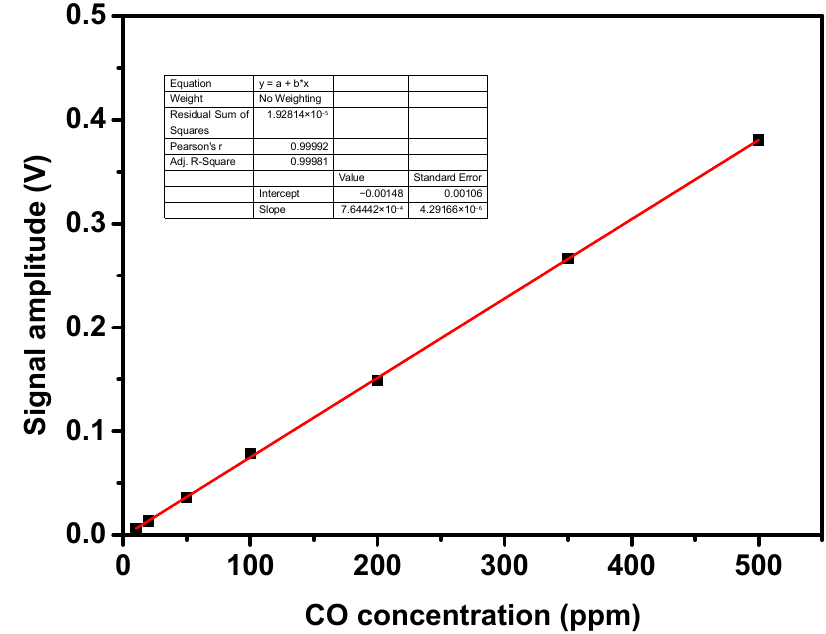
Figure 6. Linear dependence of signal amplitude versus CO gas concentration. In order to confirm the stability of our CO sensor, a long-term detection experiment of the sensor response to 10 ppm and 500 ppm CO concentration was carried out. Measured signal amplitude changes of CO over 1 h are shown in Figure 7. It is observed that the signal amplitude of CO is comparatively steady during this period. The concentration fluctuation is only about 4 ppm. These measurements show that our sensor can detect CO with high stability. The main reasons for the signal fluctuations include the drifts of